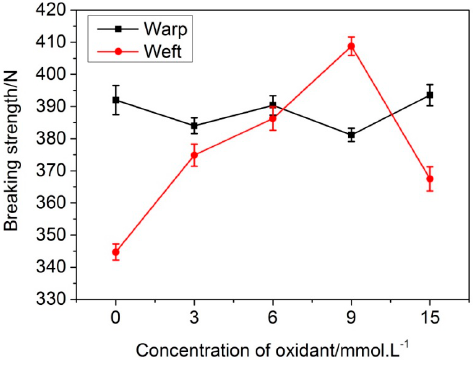
Figure 4. Effect of Ox on the strength of dyed fabric.